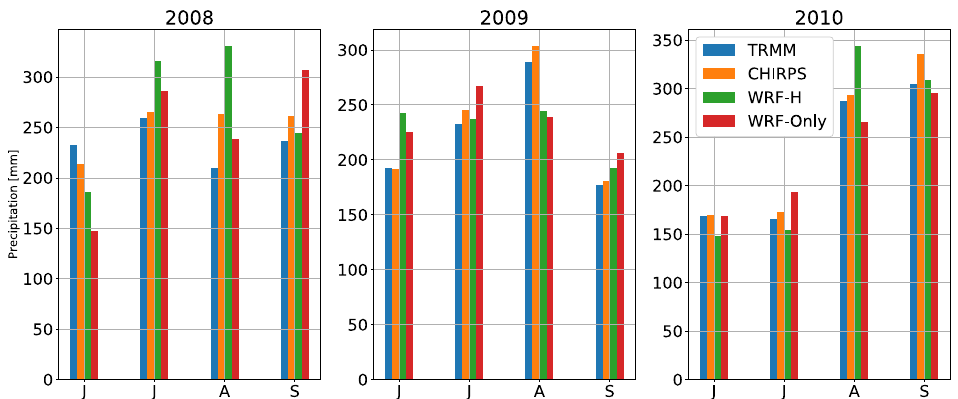
Figure 6. Precipitations trend in June–September (JJAS) at the Savè catchment for the period 2008–2010. Figure 7a,b depict the WRF-only simulations and WRF-H precipitations, respec- tively, while the difference between the two models in Figure 7c shows that WRF-H either